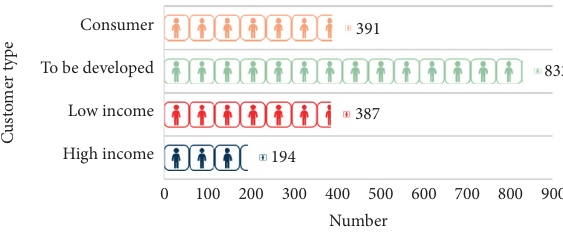
Figure 9: Distribution of the number of customers. Table 2: Customer classification standard.